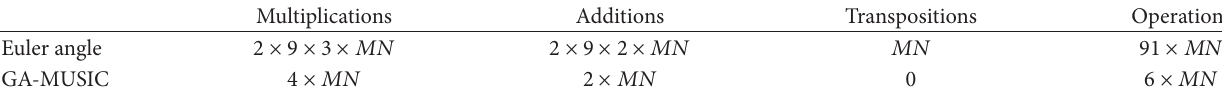
Table 2: The computational complexity of GA-MUSIC and Euler angle.